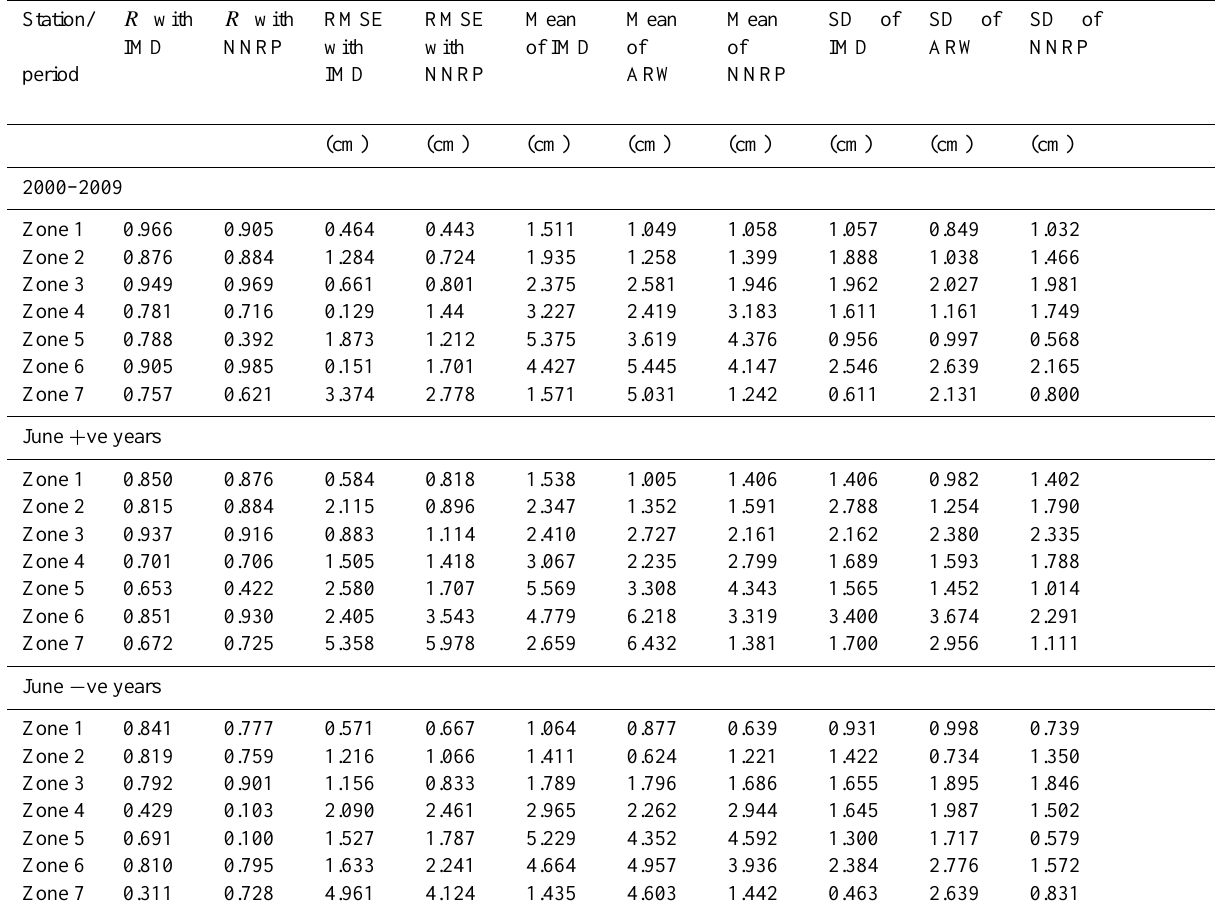
Table 3. Error metrics (correlation coefficient – R , root mean square error (RMSE)) between pentad rainfall time series based on ARW simulation, NNRP precipitation and IMD observed rainfall in different zones from 16 May to 15 July for the 2000–2009, June − ve and June + ve